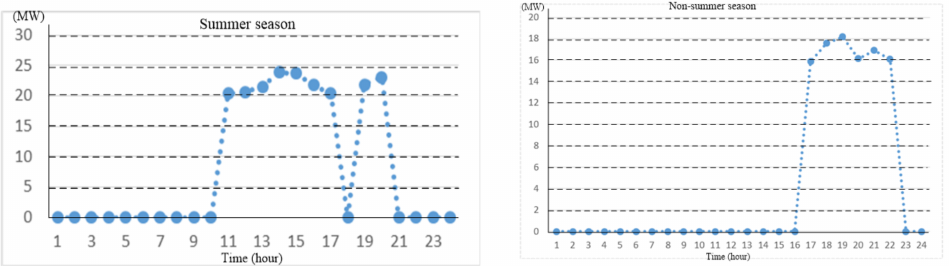
Figure 10. The daily load curtailment in the summer and non-summer